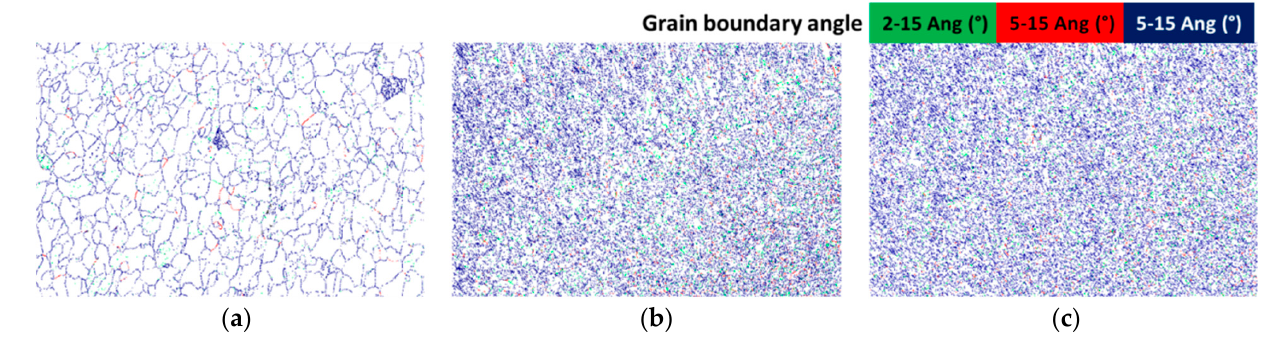
Figure 3. LAGBs for ( a ) untreated, ( b ) heated and ( c ) cryo specimens. The deep cryogenic treatment of H13 steel resulted in a fine-grained structure. As geometrically necessary dislocation (GND) density measurement by EBSD has become a very popular tool in microstructural analysis [38], Figure 4 presents the geometrically necessary dislocation evolution of untreated, heated and cryo-treated specimens. It is observed from the GND maps that the dislocation density trend is untreated < heated < cryo; the highest dislocation density is found for cryo specimens (10 14 –10 15 ), which could be attributed to increased plastic strain, resulting in accumulation of dislocations at the grain boundary areas for cryo specimens of H13 steel.